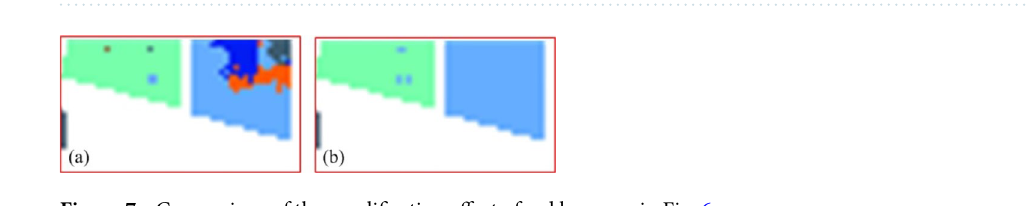
Figure 6. Experimental results of different methods and different data.